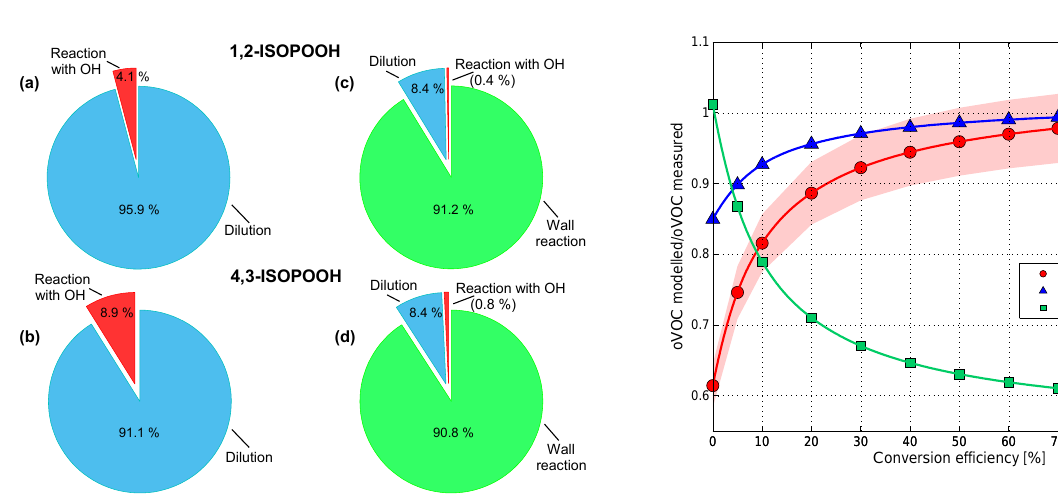
Figure 5. Relative contribution of 1,2-ISOPOOH and 4,3- ISOPOOH sinks without (a, b) and with (c, d) additional wall re- actions at an estimated wall loss rate of 1.1 × 10 − 3 s − 1 . Loss due to reaction with OH is negligible in comparison to wall loss and dilution at these low OH concentrations. More than 90% of both isomers are being lost to the chamber walls.